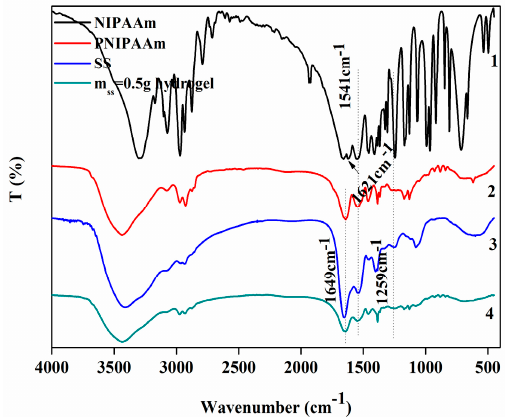
Figure 3. The FT-IR of (1) NIPAAm; (2) PNIPAAm; (3) SS; (4) m ss = 0.5 g hydrogel. Note: in the